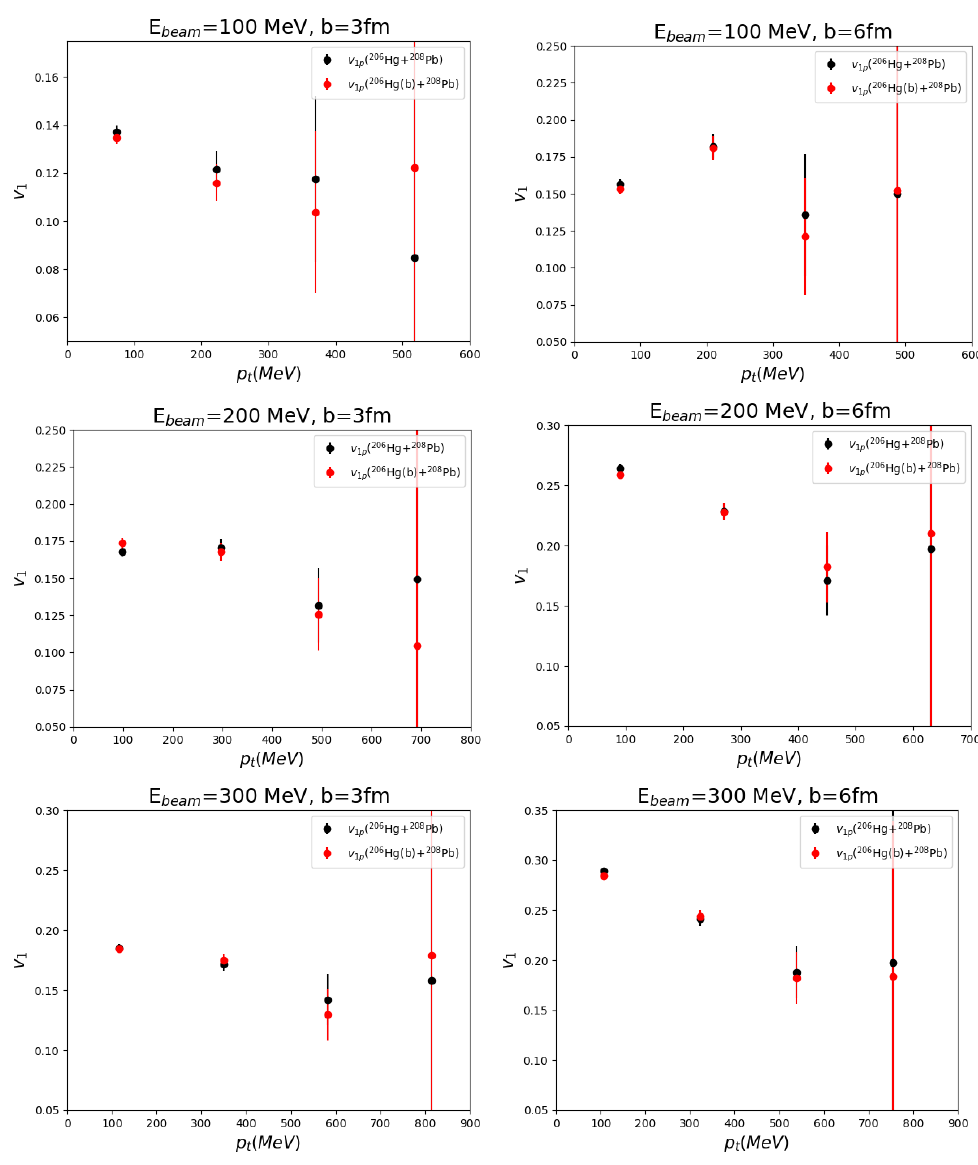
Figure 6. The directed flow v 1 of neutrons in 206 Hg (nonbubble) + 208 Pb (in black) and 206 Hg (bubble) + 208 Pb (in red)